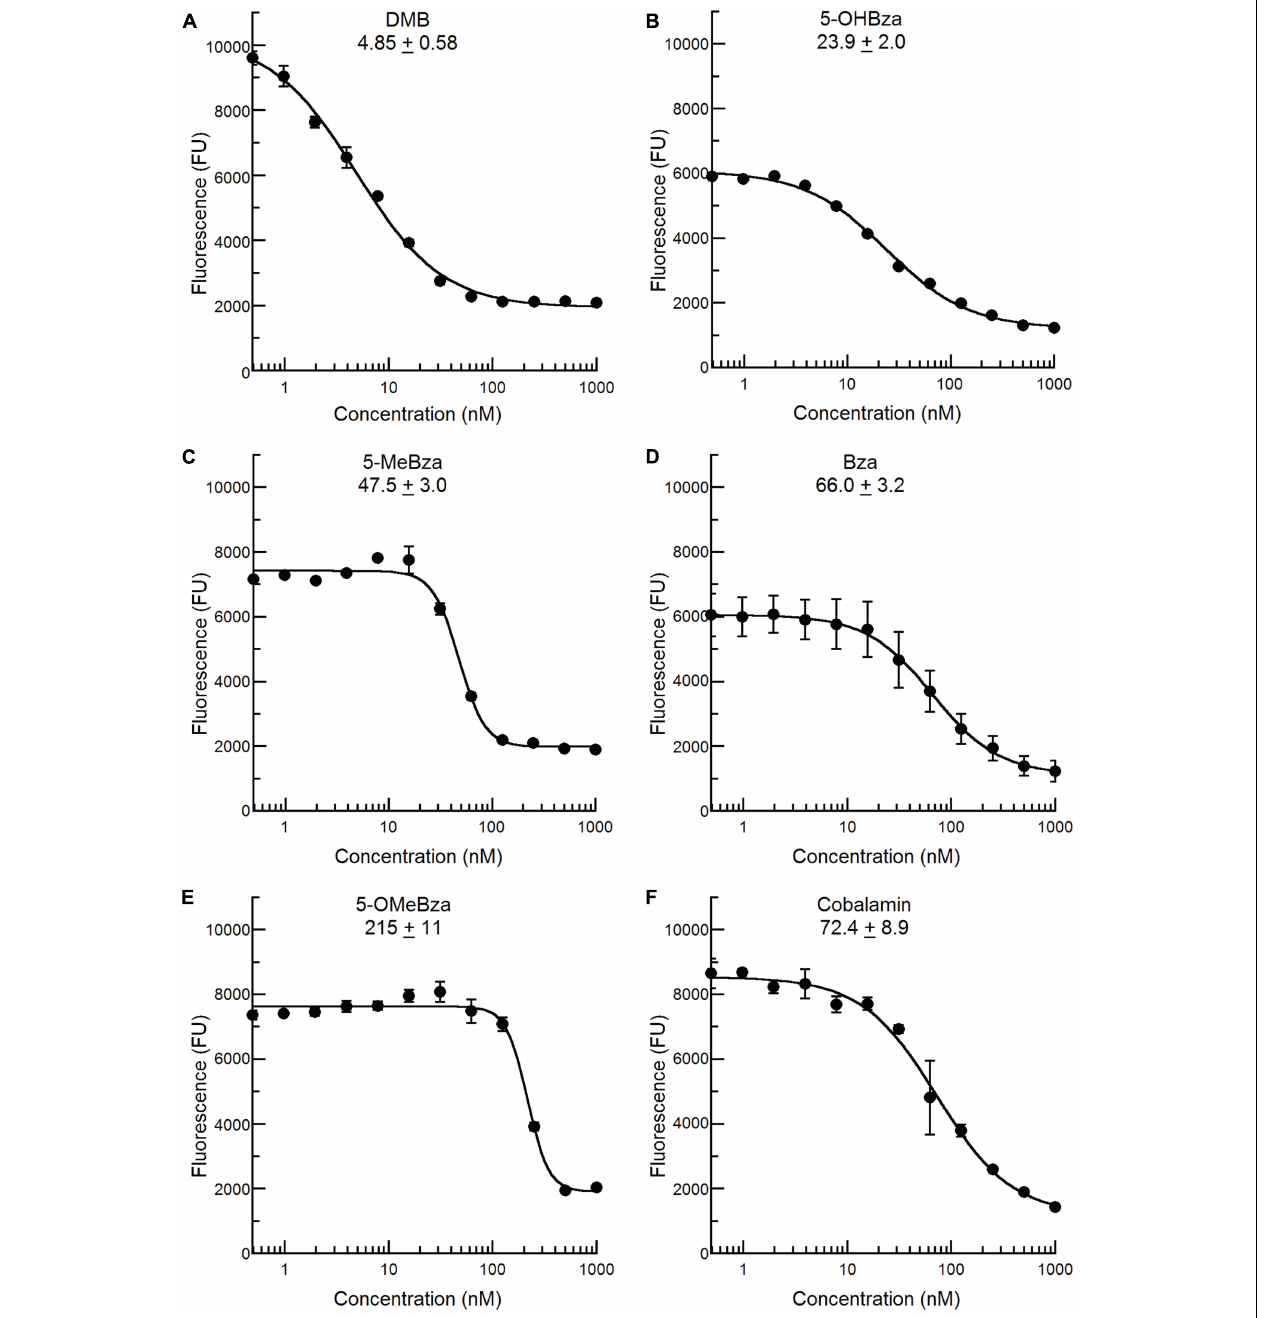
Bza, (E) 5-OMeBza, and (F) cobalamin was assayed as shown in Figure 3D . The EC 50 of each compound and curve-fit error are indicated on each graph. Error bars represent the SE of three independent